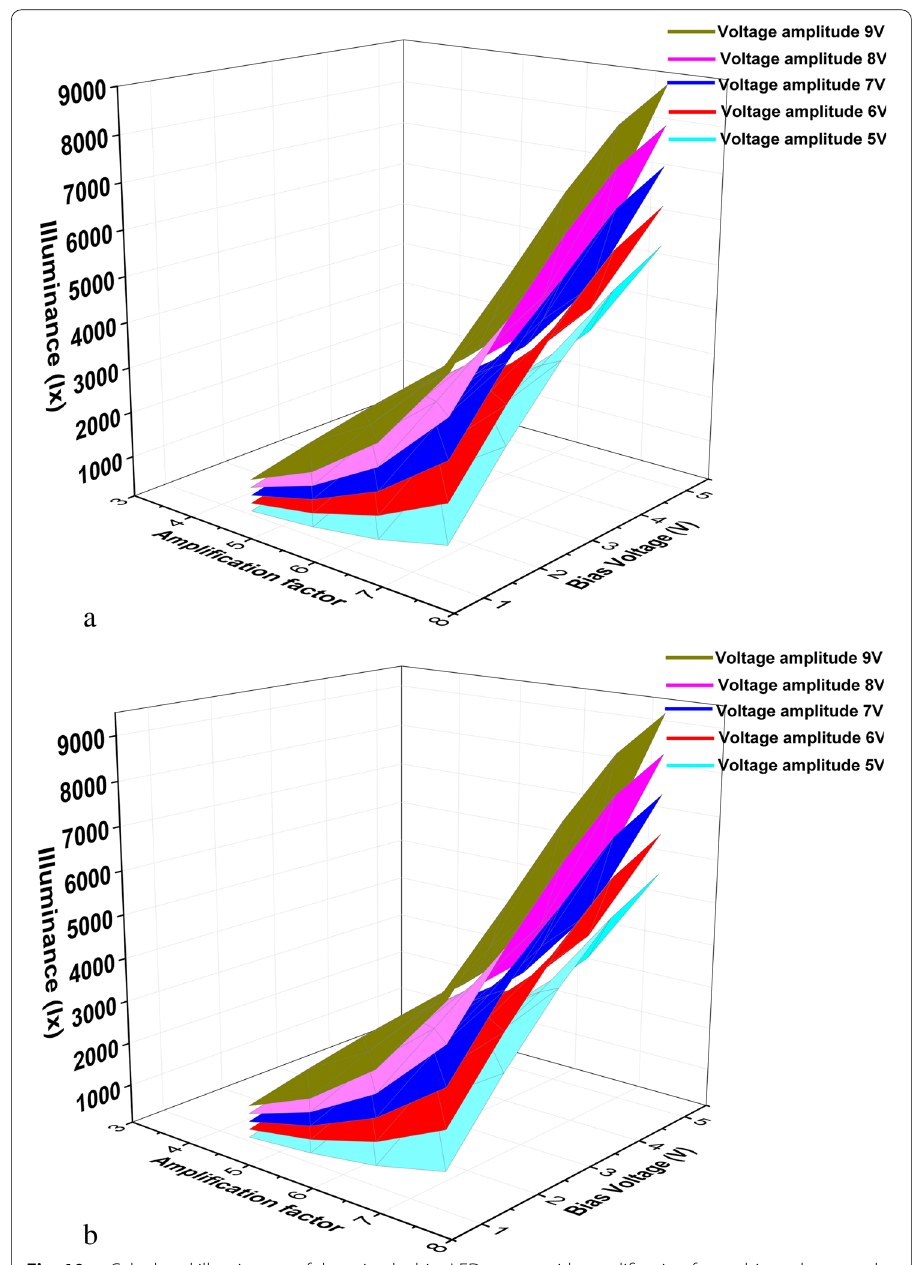
voltage, and voltage